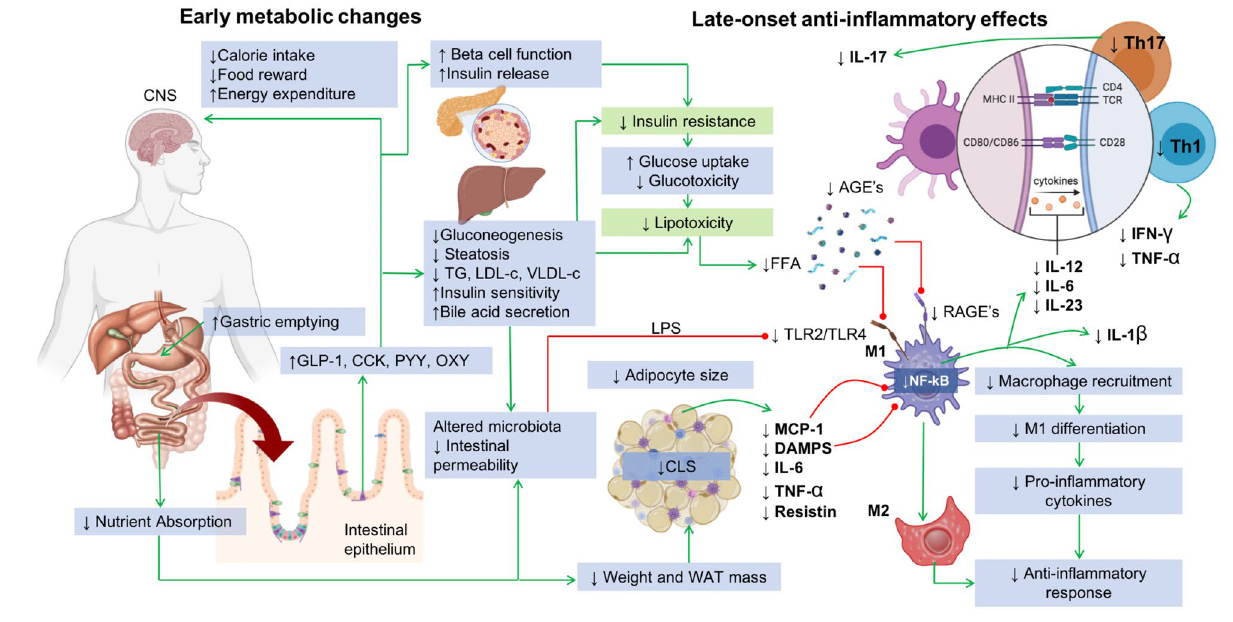
Figure 4. Mechanisms involved in the production of late-onset anti-inflammatory response as a result of early metabolic changes associated with bariatric and metabolic surgery. Green lines indicate pathway activation whereas red lines indicate pathway inhibition. Upper arrows indicate increase and down arrows indicate decrease. GLP-1: Glucagon-like peptide-1; CCK: Cholecystokinin; PYY: Y-Y Peptide; OXY: Oxyntomodulin; TG: Triglycerides; LDL-c: Low density lipoprotein cholesterol; VLDL-c: Very low density lipoprotein cholesterol; LPS: Lipopolysaccharide; FFA: Free fatty acids; TLR: Toll-like receptor; AGE’s: Advanced glycation end products; RAGE’s: Advanced glycation end product receptors; MCP-1: Monocyte chemotactic protein-1; Th1: Type 1 T-helper lymphocyte; Th17: Type 17 T-helper lymphocyte; DAMPS: Damage-associated molecular patterns; M1: M1 Macrophages; M2: M2 Macrophages; IFN-γ: Gamma interferon; TNF-α: Tumor necrosis factor alpha; IL: Interleukin; MHC-II: Mayor histocompatibility complex class II; NF-kB: Nuclear factor kappa-B; TCR: T-Cell receptor; CD: Cluster of differentiation; CLS: Crown-like structures. Figure made by Eder-Luna using Biorender drawing